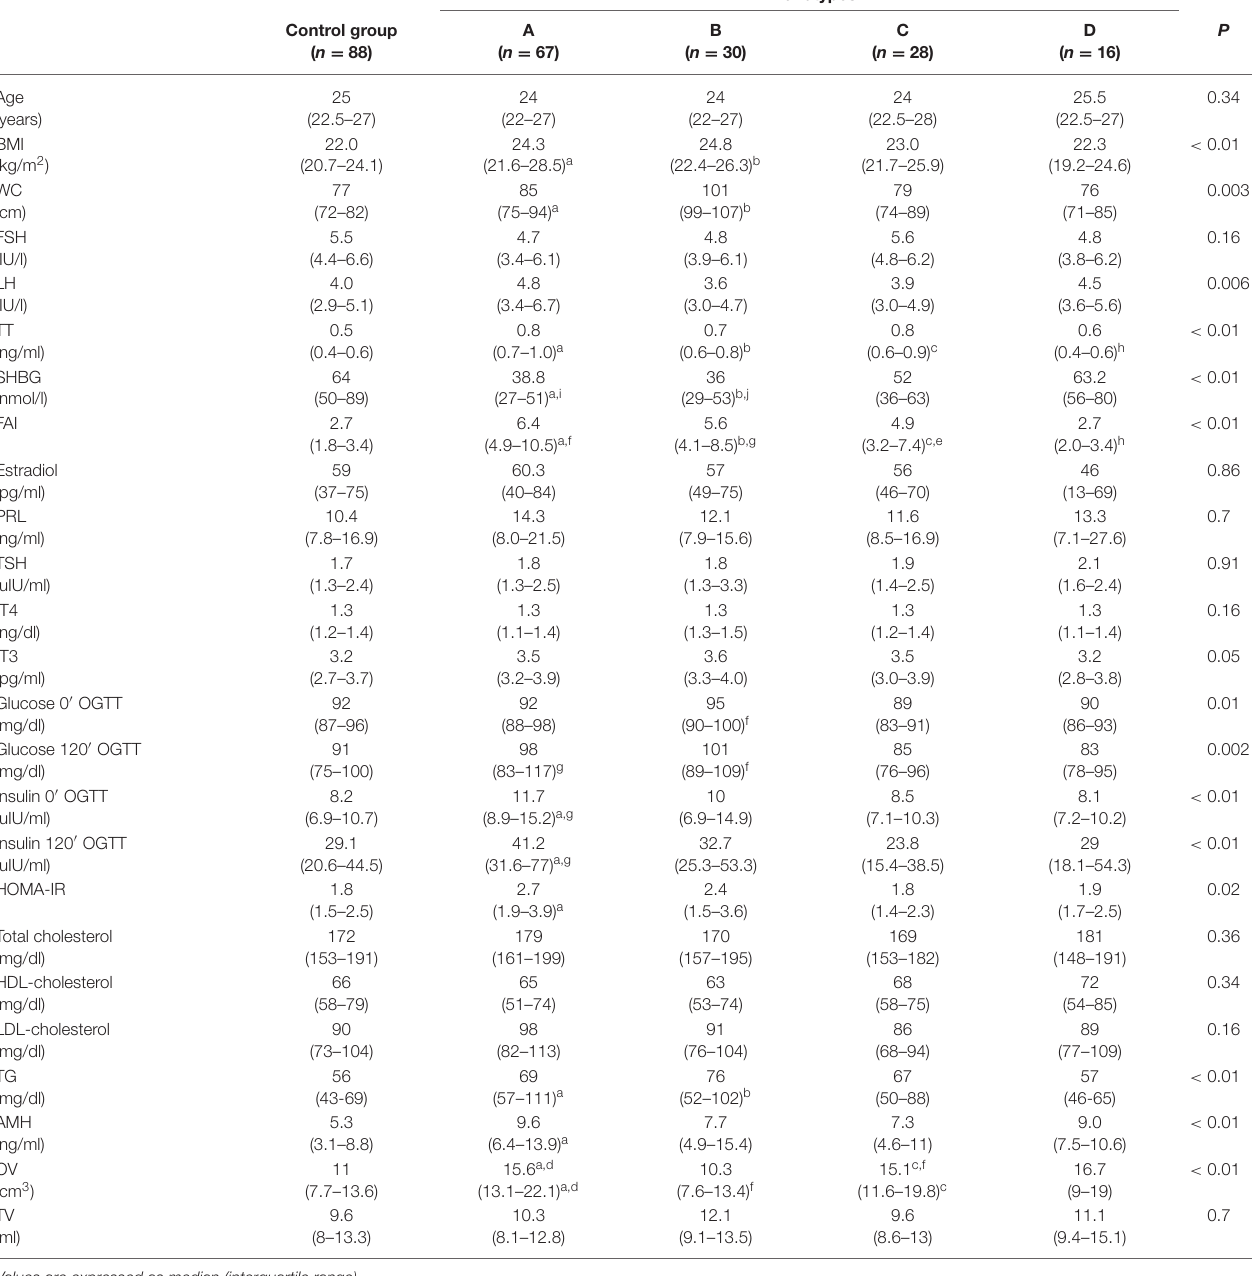
TABLE 1 | Clinical and biochemical characteristics of the studied